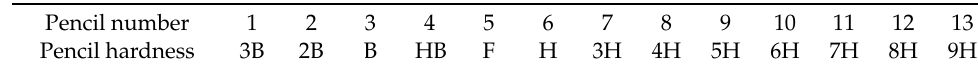
Table 3. Degrees of film hardness by the Pencil test.